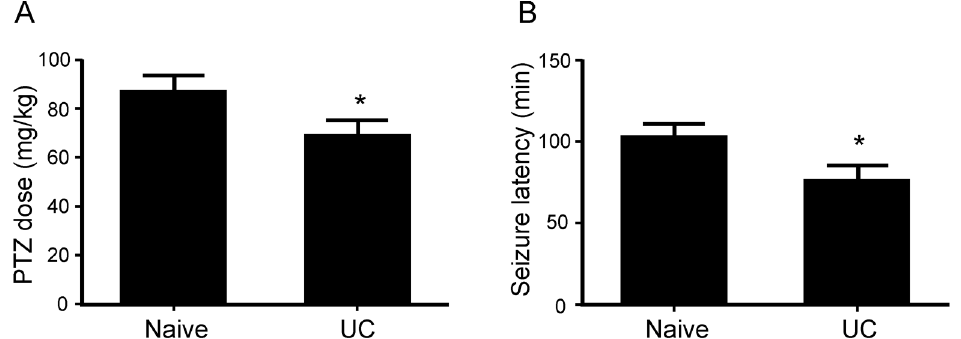
Fig 4. Reduced seizure threshold in undercut mice. Undercut mice received PTZ test at 15 days after undercut lesion. There were significant decreases in the cumulative dose of PTZ for seizure induction (A) and the latency period to first seizure (B) in the undercut than in the na ï ve mice. * : p < 0.05, Student t -test.